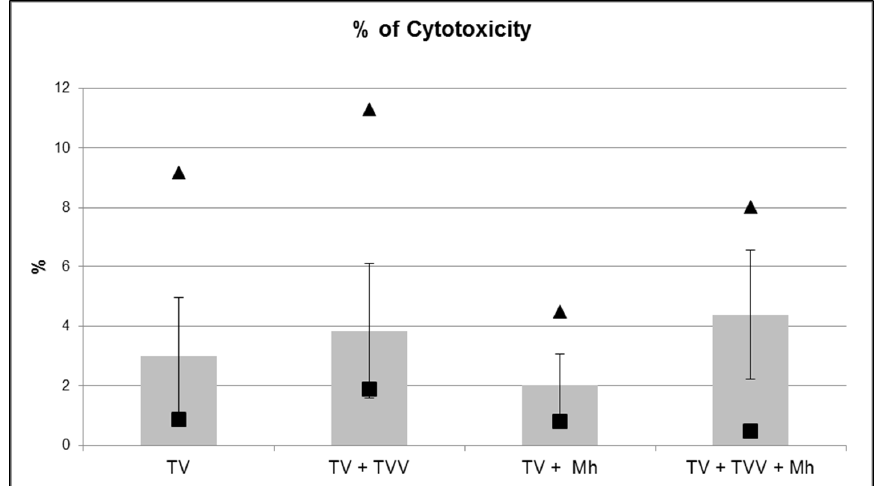
Figure 2. Mean percentages of T. vaginalis cytotoxicity of isolates without endosymbionts (TV), carrying TVVs (TV + TVV), carrying M. hominis (TV + Mh), and carrying TVVs and M. hominis (TV + TVV + Mh). Minimal (black squares) and maximal (black triangles) values of cytotoxicity are pointed.